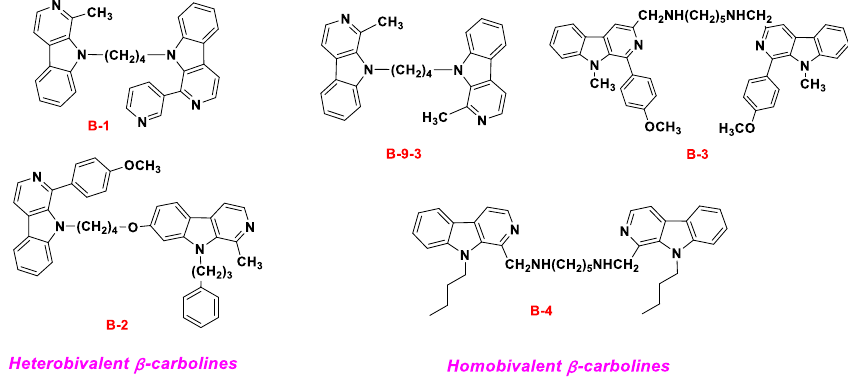
Figure 2. The chemical structure of the representative reported diremic β-carbolines.